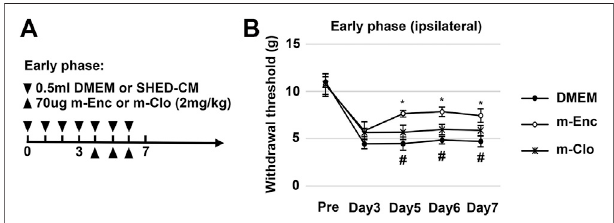
FIGURE 5 | Effects of M2 depletion on SHED-CM-mediated behavioral recovery after PSL. (A) Time course of M2 depletion in the early phase model. After PSL, mice were daily administered with either 0.5 ml of SHED-CM or DMEM. From day 4 to 6, mannosylated-Clodrosome (m-Clo; for M2 depletion) or mannosylated-Encapsome (m-Enc; negative control) were injected together with SHED-CM. (B) The ipsilateral paw withdrawal thresholds. m-Clo, but not m-Enc, signi fi cantly inhibits the antinociceptive effects of SHED-CM. Notably, the paw withdrawal threshold in the m-Clo group was signi fi cantly higher than that in the DMEM group. Tukey ’ s multiple comparisons of means ( n = 10, per group). Data represent the mean ± SD. * p < 0.05, for the m-Clo vs. m-Enc. # p < 0.05 for the m-Clo vs. DMEM.